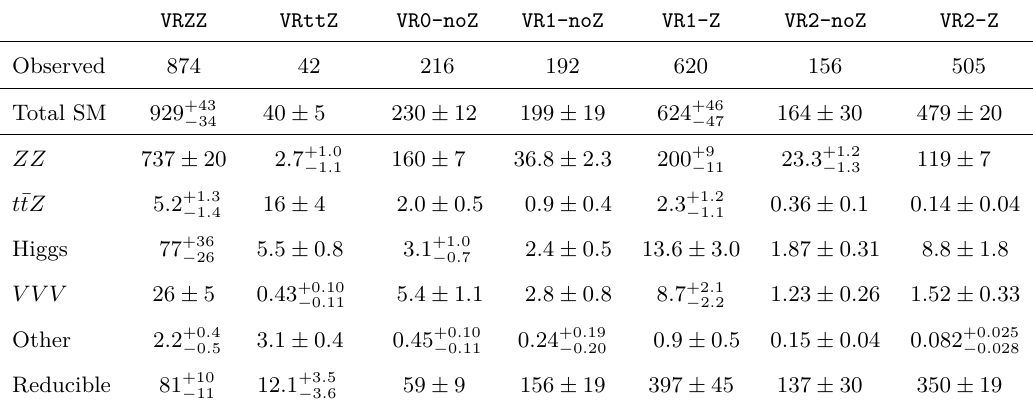
Table 8. Expected and observed yields for 139 fb − 1 in the validation regions after the background- only fit. “Other” is the sum of the tWZ , t ¯ tWW , t ¯ tZZ , t ¯ tWZ , t ¯ tWH , t ¯ tHH , t ¯ ttW , and t ¯ tt ¯ t backgrounds. Both the statistical and systematic uncertainties in the SM background are included in the uncertainties